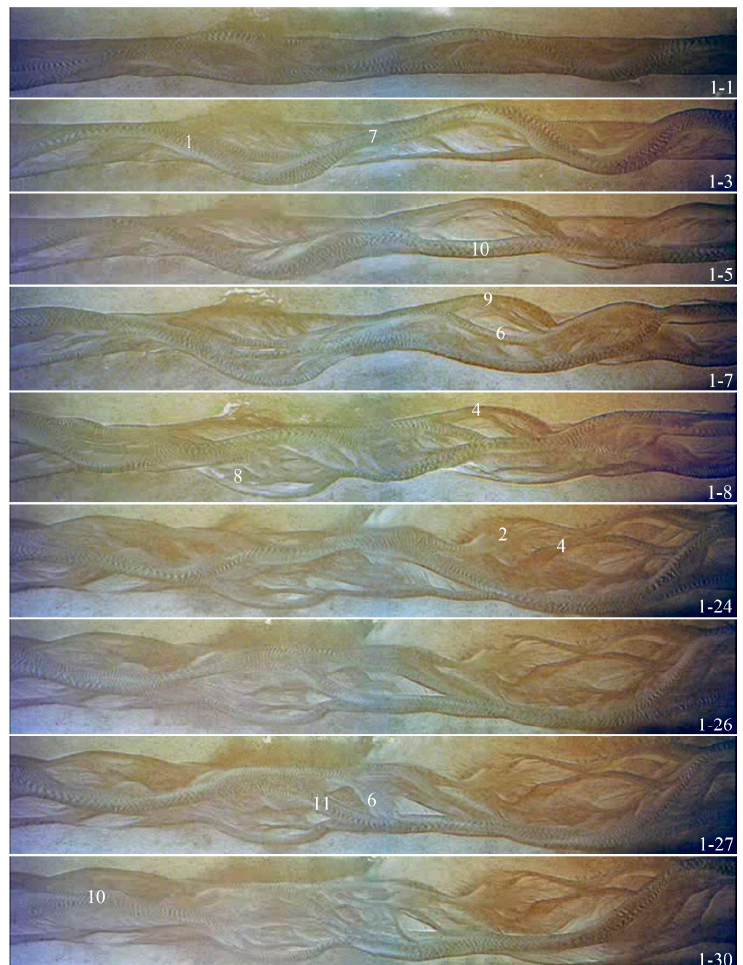
Figure 5. Morphologic changes and activities during the evolution process of the experimental